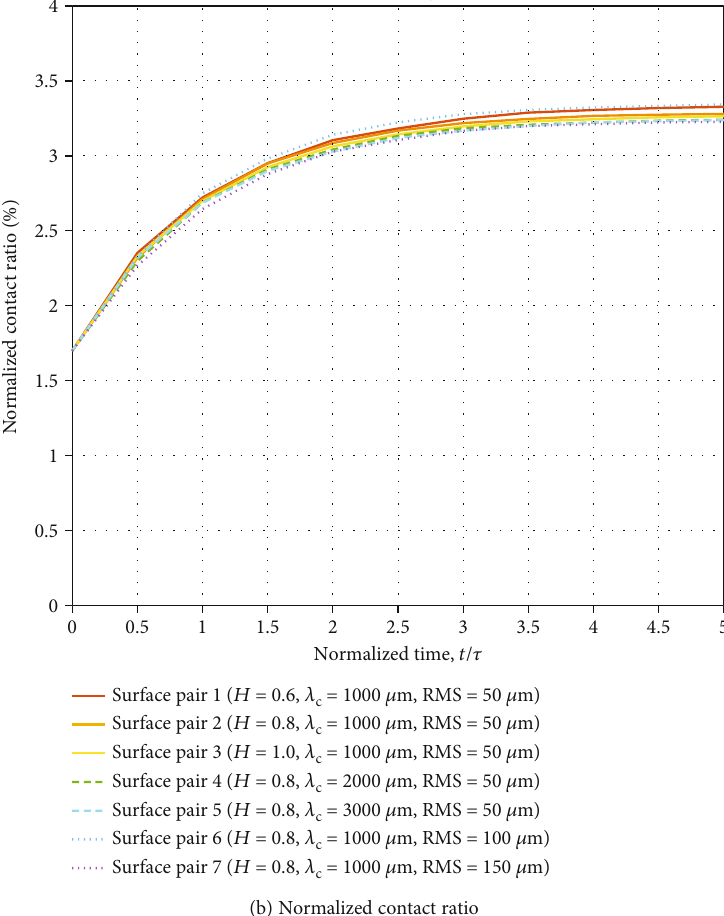
Figure 21: Normalized mean aperture and contact ratio of the seven surface pairs (shown in Table 3). The time t is normalized by τ . (a) Normalized mean aperture changing with time for the seven surface pairs; (b) normalized contact ratio changing with time for the seven surface pairs. The formulae for normalized mean aperture and normalized contact ratio are shown in Equations (39) and (40),